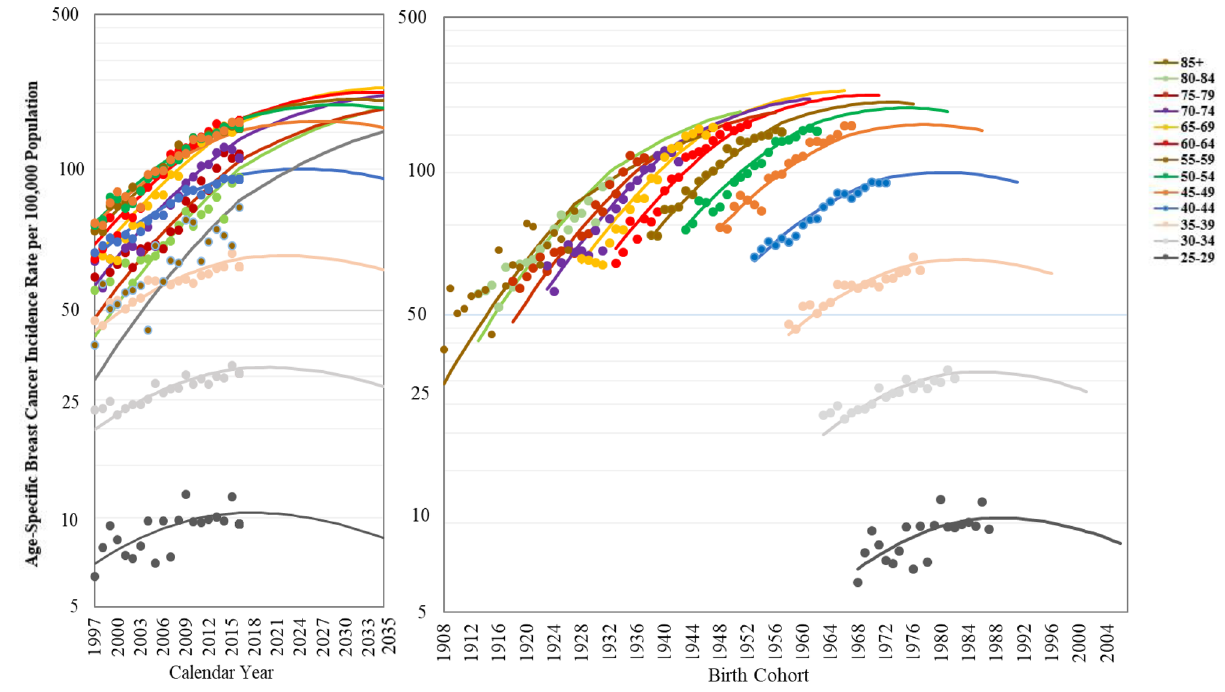
Figure 2. Age-specific breast cancer incidence rate from 1997 to 2016 and projections from 2017 to 2035 for calendar year and birth